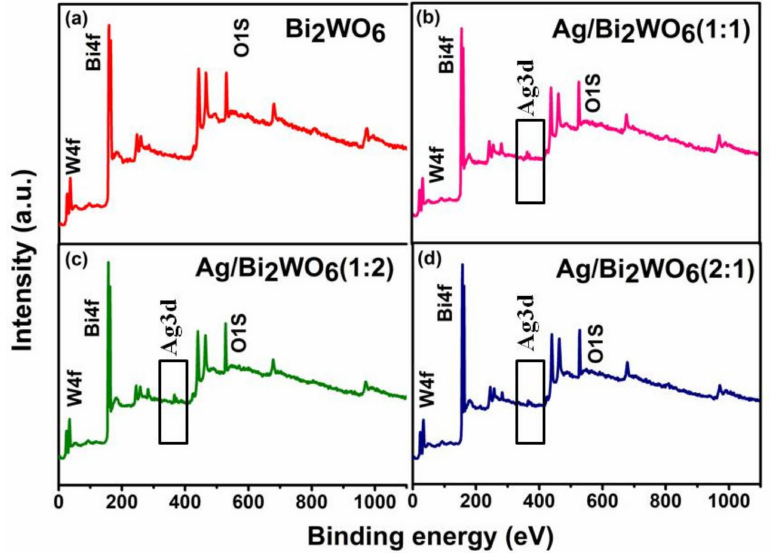
Figure 8. Overall XPS spectra of ( a ) Bi 2 WO 6 ; ( b ) Ag/Bi 2 WO 6 (1:1); ( c ) Ag/Bi 2 WO 6 (1:2); ( d ) Ag/Bi 2 WO 6